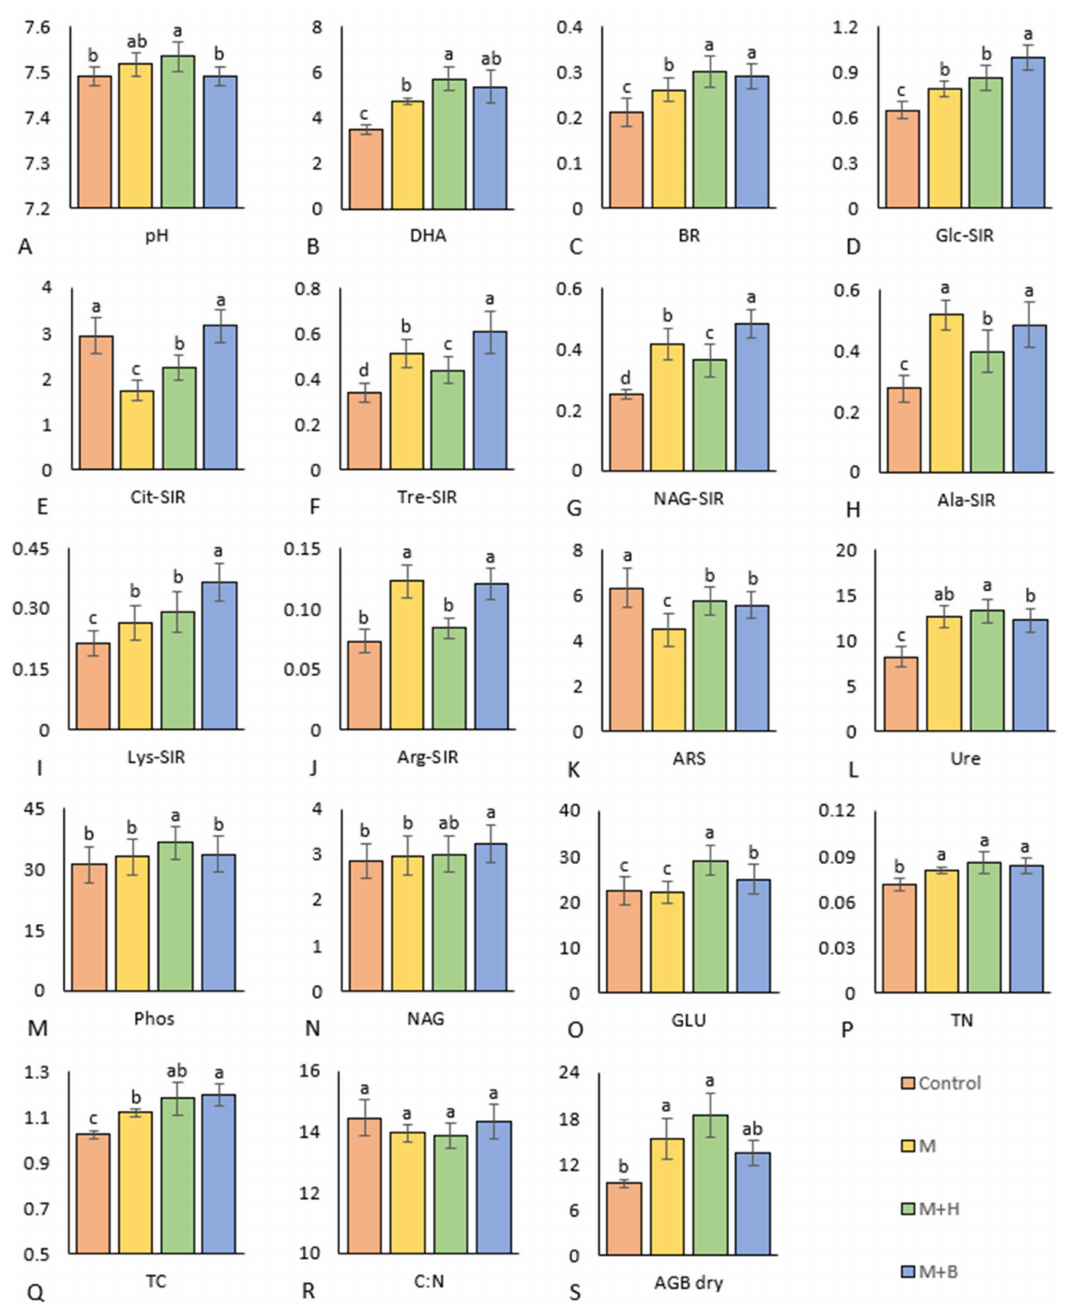
Figure 1. Results of the pot experiment with four tested variants, i.e., soil (control), soil amended with manure (M), soil amended with manure and Humac (M + H), and soil amended with ma- nure and biochar (M + B) . The measured parameters were as follows: ( A ) soil reaction = pH [-], ( B ) dehydrogenase activity [ µ g TPF · g − 1 · h − 1 ], ( C ) basal respiration [ µ g CO 2 · g − 1 · h − 1 ], ( D ) D - glucose SIR [ µ g CO 2 · g − 1 · h − 1 ], ( E ) citric acid SIR [ µ g CO 2 · g − 1 · h − 1 ], ( F ) D -trehalose SIR, ( G ) N -acetyl- · g − 1 · h − 1 ], ( H ) L -alanine SIR [ µ g CO · g − 1 · h − 1 ], ( I ) L-lysine SIR β - D -glucosamine SIR [ µ g CO 2 2 [ µ g CO 2 · g − 1 · h − 1 ], ( J ) L -arginine SIR [ µ g CO 2 · g − 1 · h − 1 ], ( K ) arylsulfatase [nmol · g − 1 · min − 1 ], ( L ) ure- ase [nmol · g − 1 · min − 1 ], ( M ) phosphatase [nmol · g − 1 · min − 1 ], ( N ) N -acetyl- β - D -glucosaminidase [nmol · g − 1 · min − 1 ], ( O ) β -glucosidase [nmol · g − 1 · min − 1 ], ( P ) total soil nitrogen [%], ( Q ) total soil car- bon [%], ( R ) C:N ratio [-], ( S ) dry plant aboveground biomass [g]. Different letters indicate differences between the values at the statistical level of significance p ≤